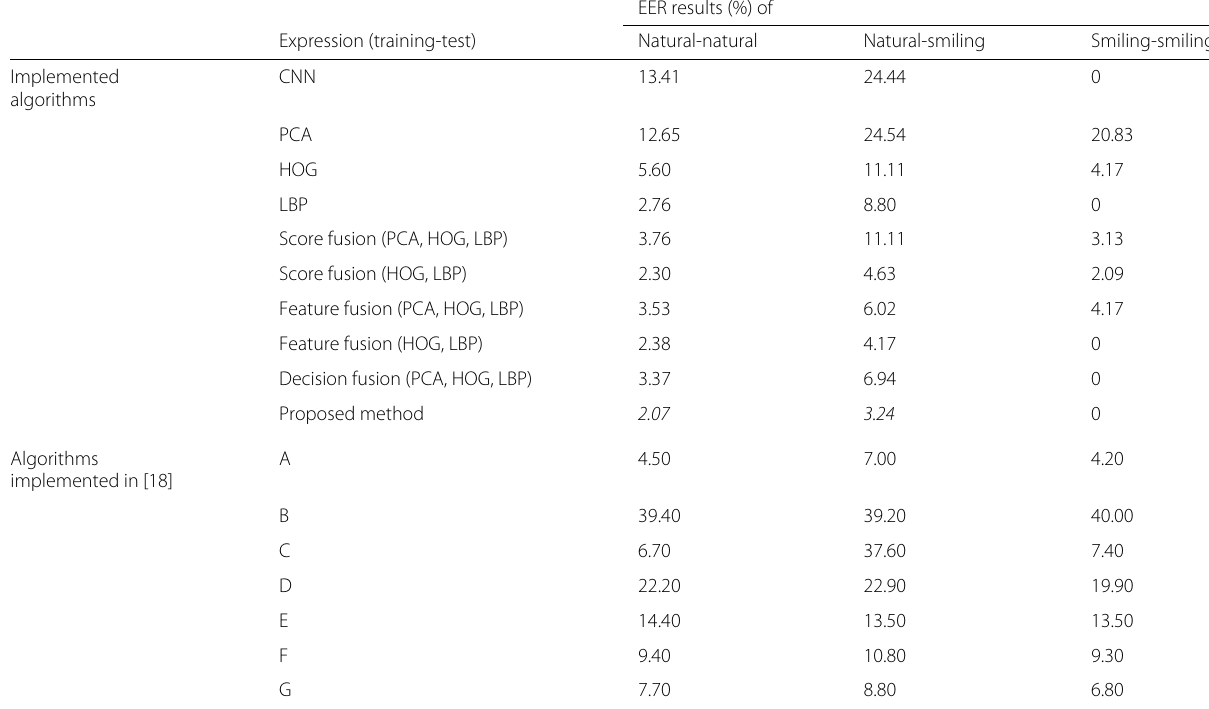
Table 2 EER results of expression-based experiments for identical twins EER results (%) of Expression (training-test) Natural-natural Natural-smiling Smiling-smiling Implemented algorithms